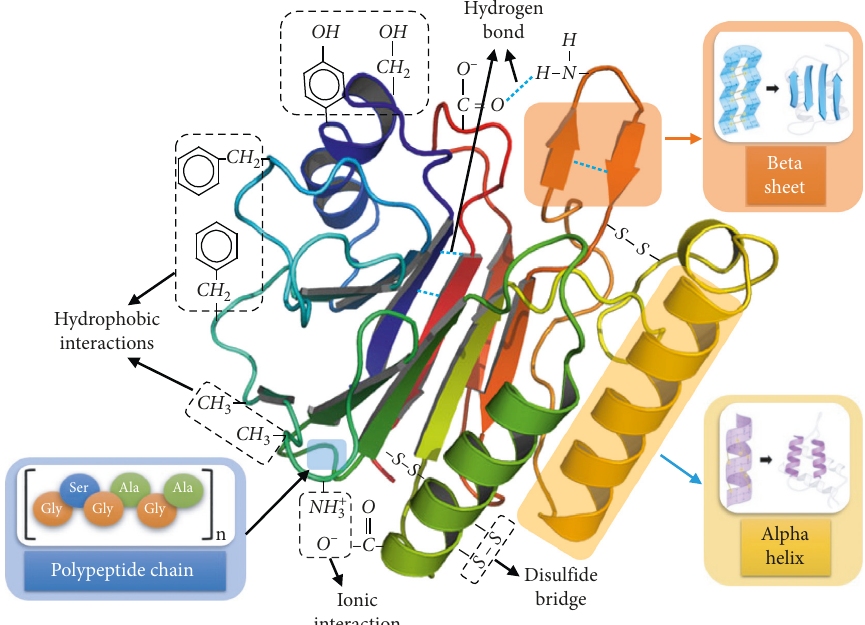
Figure 1: The different interactions that maintain the stability of the protein structures (edited by the author